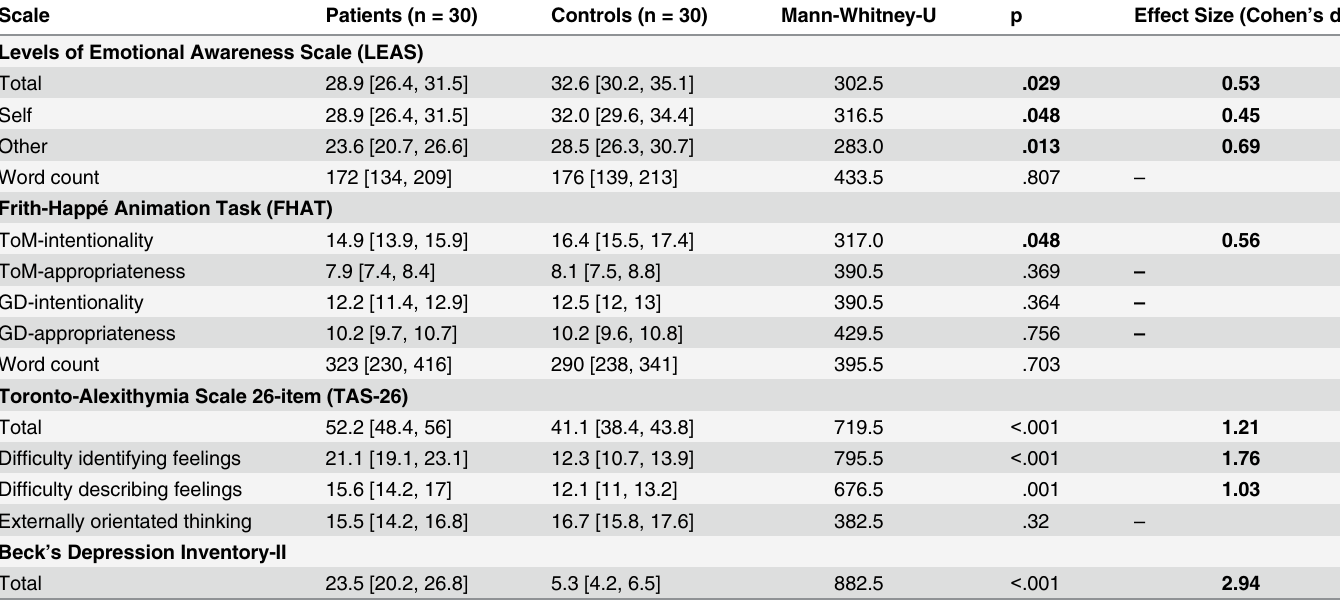
Table 2. Results for performance measures and questionnaires.